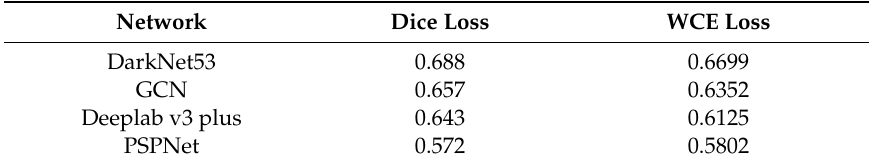
Table 3. Results of wall segmentation with R-FP datasets.